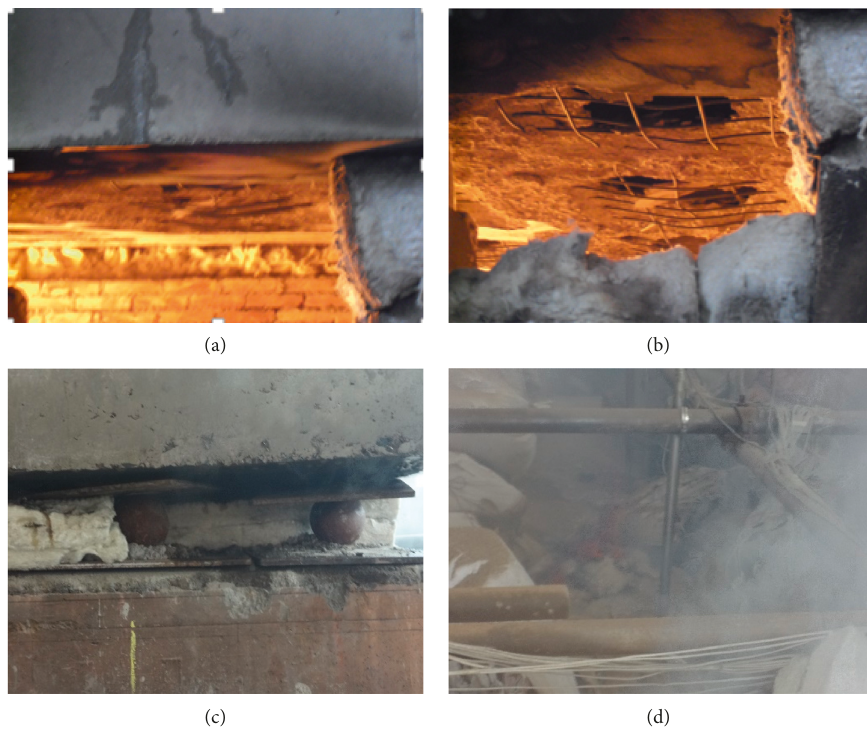
Figure 6: Fire test of the open box. (a) 5 minutes. (b) 15 minutes. (c) 35 minutes. (d) 69 minutes.